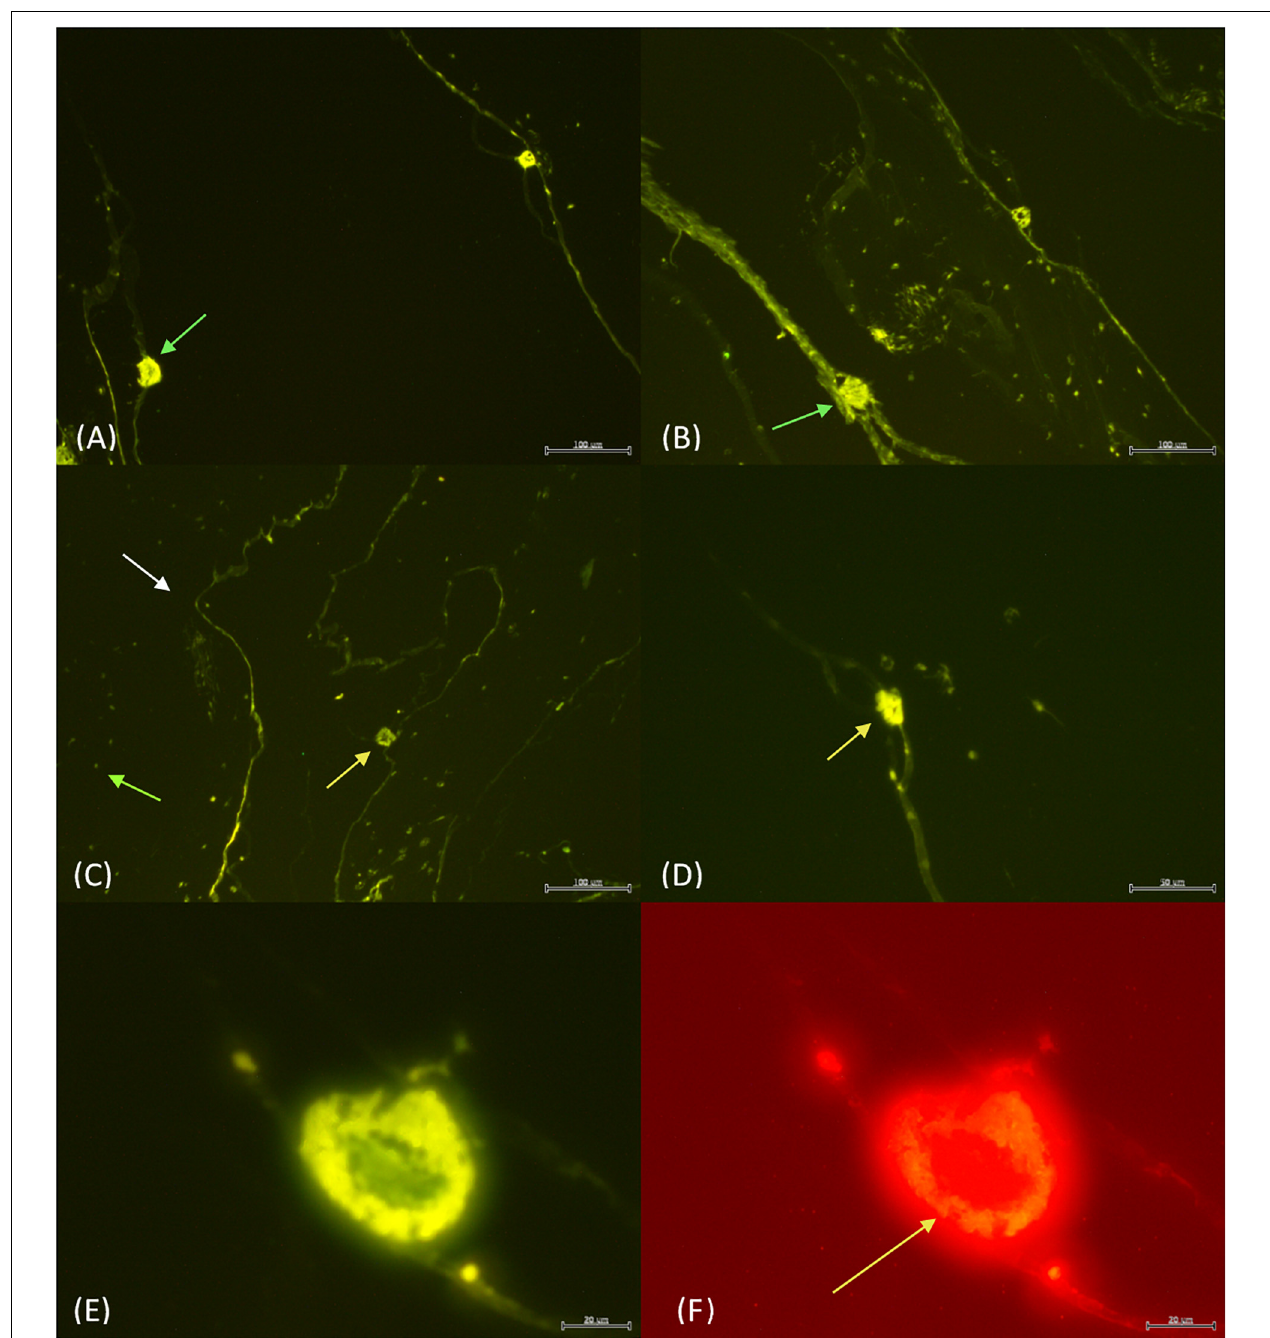
FIGURE 3 | The light organs (green arrows) with no probe and the shutter wide open (A) vs. 4 µ l of both EUB338 and Photobacterium probe with the shutter partially closed (B) . The EUB338 probe (C) binds to many bacteria (green arrow) within the tunic (white arrow) and the light organ (yellow arrow). In contrast, the Photobacterium probe (D) only illuminated the light organ. EUB338 and Photobacterium probes in green (E) vs. red (F) . The orange fluorescence in Photobacterium Pa-1 is found exclusively concentrated around the edges of the light organ (yellow arrow). Scale bar = 100 µ m in (A–C) , while the scale bar is 50 µ m (D) , and 20 µ m in